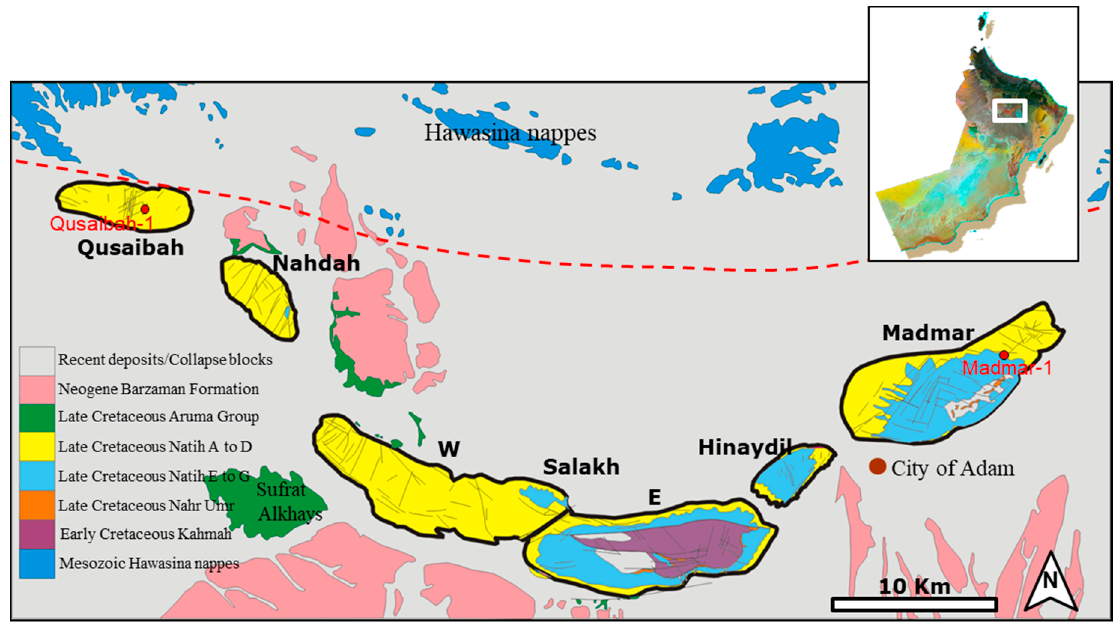
Figure 2. A Geological map of the Salakh Arch. The dashed red line indicates the inferred location of the Hawasina nappes front.